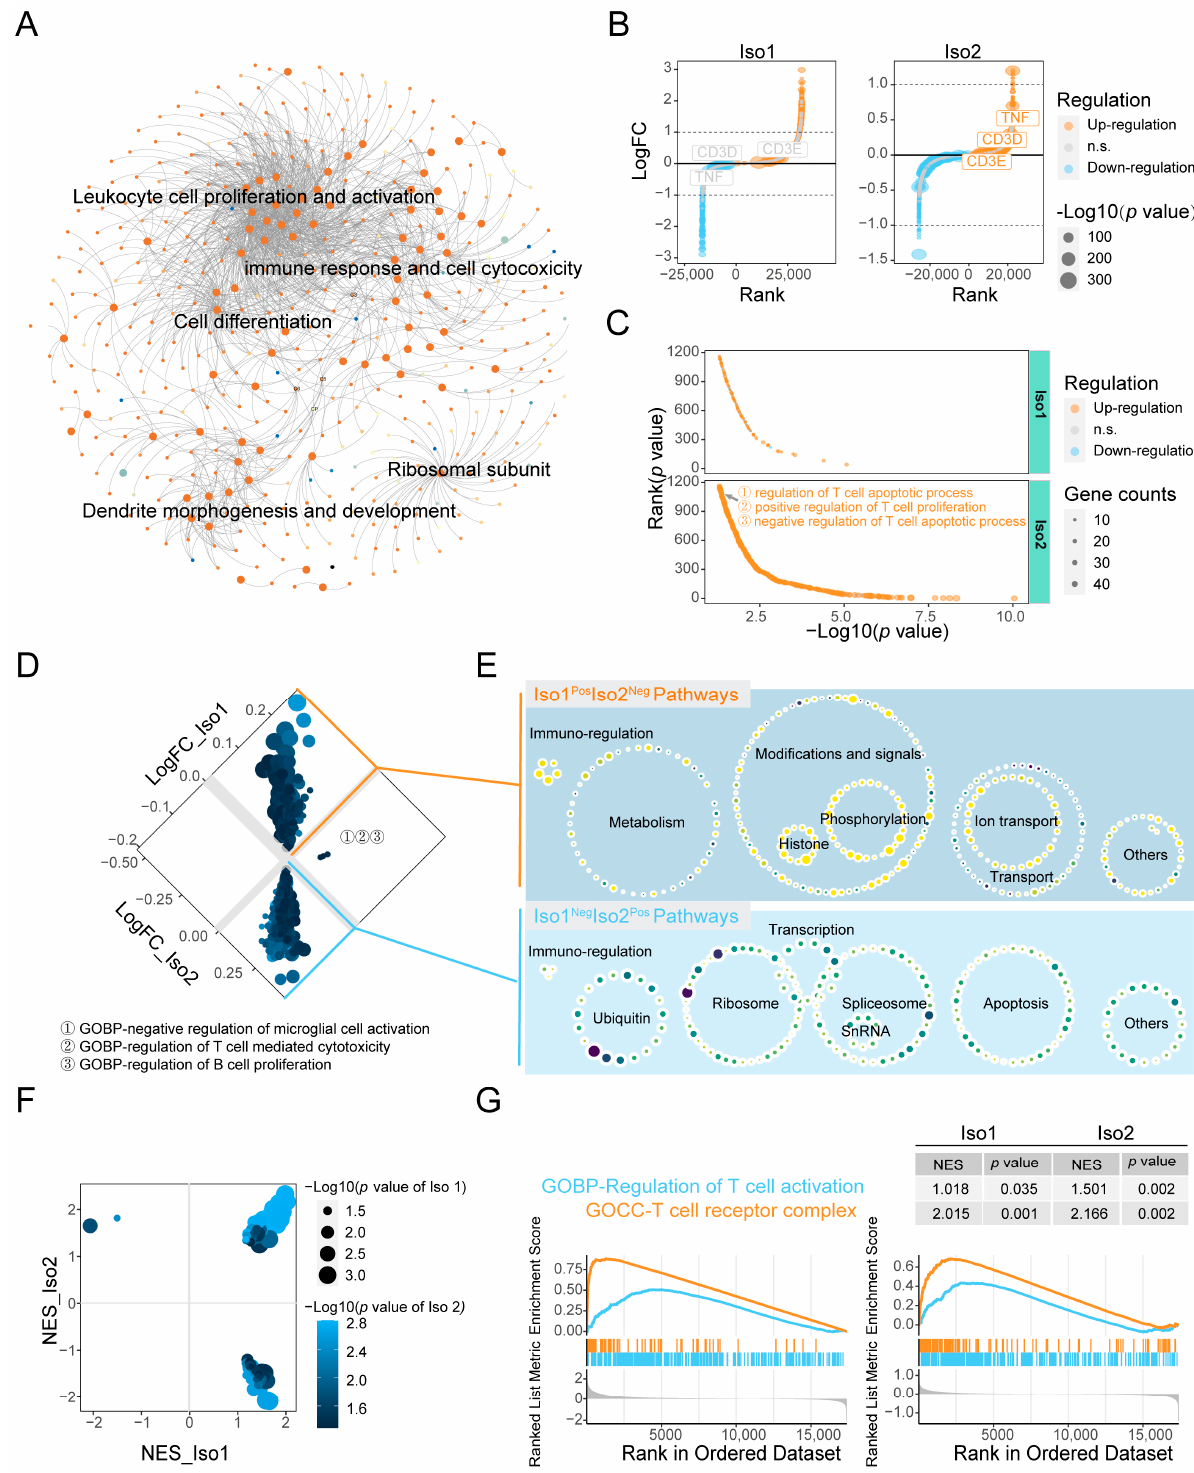
Figure 3. The similar and di ff erent functions between two mPD-L1 isoforms. ( A ) An integration network composed of Iso2-associated genes and pathways. ( B ) Iso1 and Iso2-associated DEGs analysis between positive and negative groups. ( C ) Functional enrichments of Iso1- and Iso2-associated DEGs. ( D ) Di ff erential analysis of Iso1 and Iso2-associated GSVA pathways. ( E ) Distinct biology functions in Iso1 Pos Iso2 Neg and Iso1 Neg Iso2 Pos groups. ( F ) GSEA analysis of the associated functions of Iso1 and Iso2. ( G ) The representative GSEA results, in which Iso1 and Iso2 conferred similar e ff ects.